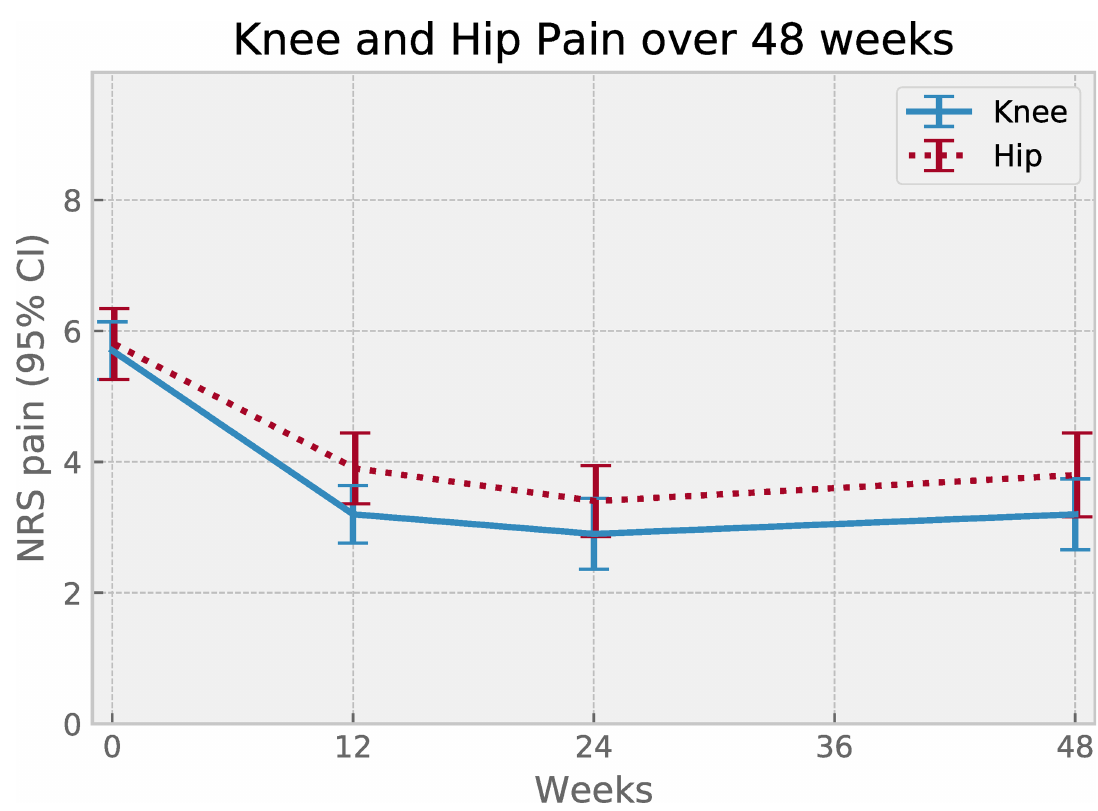
Fig 4. Pain change over time, per index joint, for the 0 to 48-week subgroup of patients. Symbols show mean pain value at 0, 12, 24 and 48 weeks for patient subgroups with index joint knee (n = 78) or hip (n = 60). Error bars represent 95% confidence intervals.